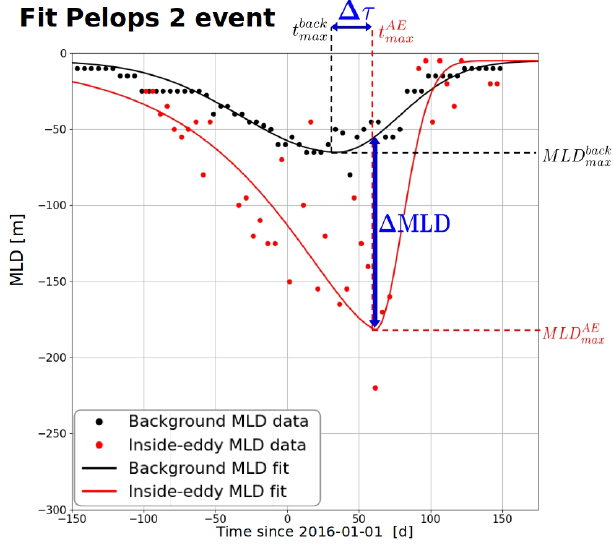
Figure 3. Detail of winter deepening event Pelops (PEL) 2 in 2016 (see Table 1 for details). Anticyclonic core MLD data are shown as red dots, and background MLDs are shown as black dots, with time steps of 5d. MLD fit is shown as a red line for the anticyclonic core (see Eq. 2) and as a black line for background MLD (see Eq.